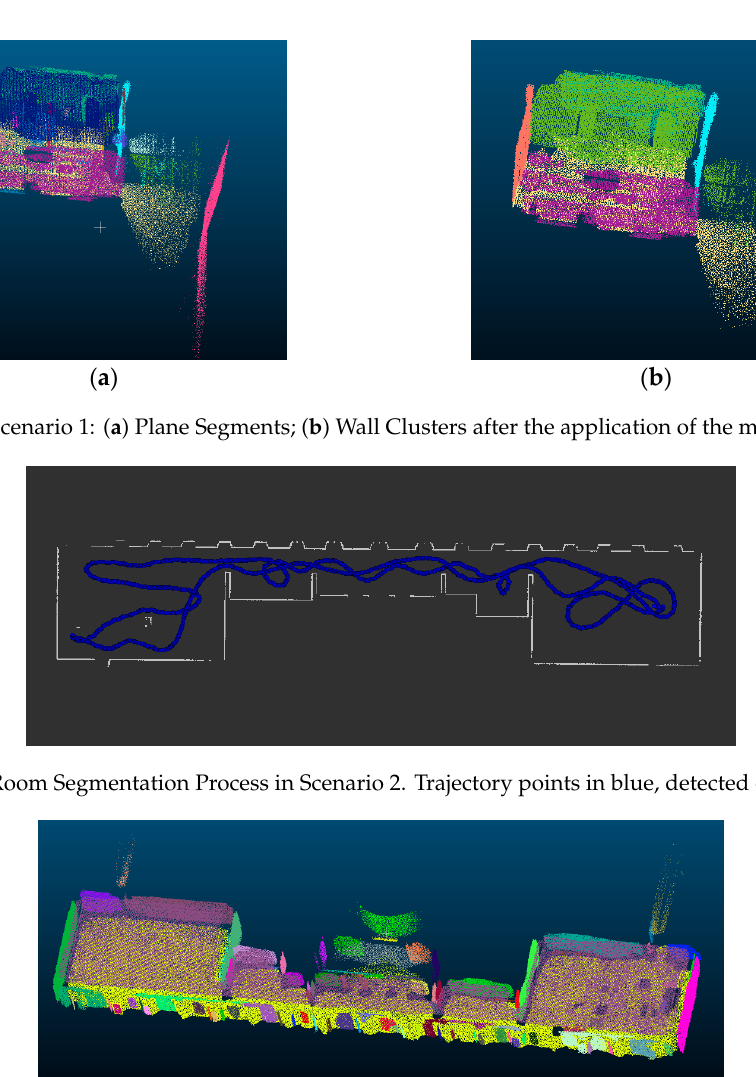
Figure 16. Scenario 2 Wall Clusters. When the planes of the walls are intersected (2 from group XY, 4 from group XZ and 4 from group YZ), 32 intersection points are obtained. This is produced, as shown in Section 2, because of the intersection of some planes, which have a mathematic intersection but no real contact between the walls represented by them. Thus, the estimated virtual intersection points are 32, but after evaluating which of these points are vertexes, an amount of 16 real vertexes is obtained. In Figure 17, a schema of the problem for this scenario is shown. Although this part of the system is supervised by the user and needs his approval, it is tested that no problem appears if the previous clustering process is correct.